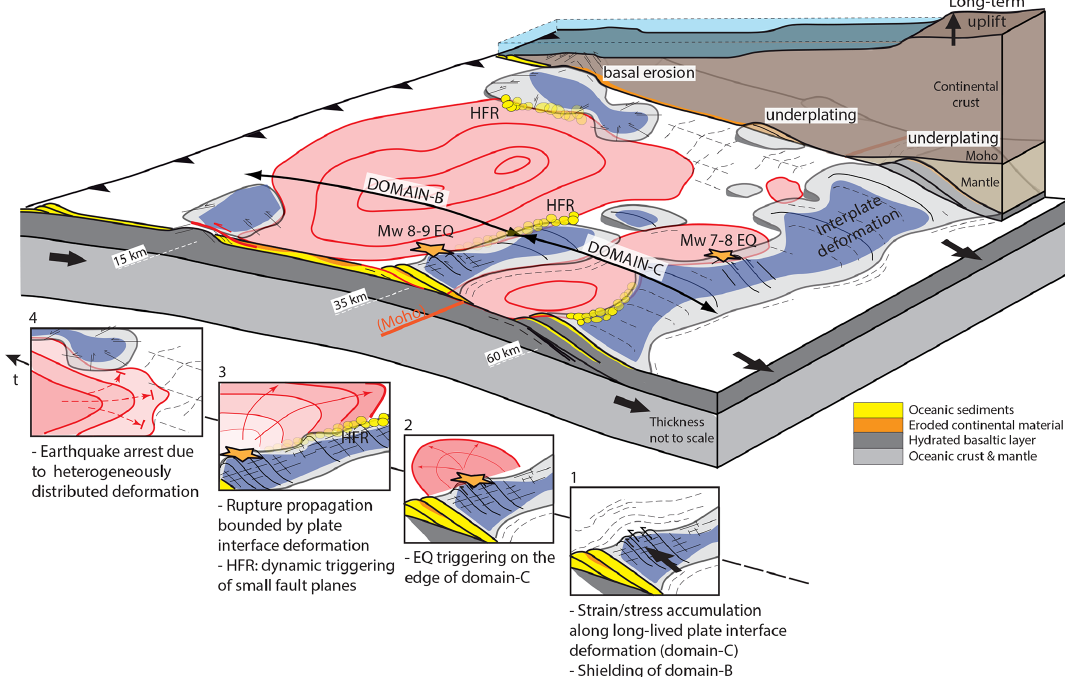
Figure 7. 3D view of the subduction plate interface depicting the mutual spatial relationships between earthquake ruptures (in red) and longer-lived deformation determined from the CTT analysis (blue patches). Stages 1–4 illustrate how this deformation controls the triggering and limits seismic ruptures. HFR: high-frequency radiation. See text for further